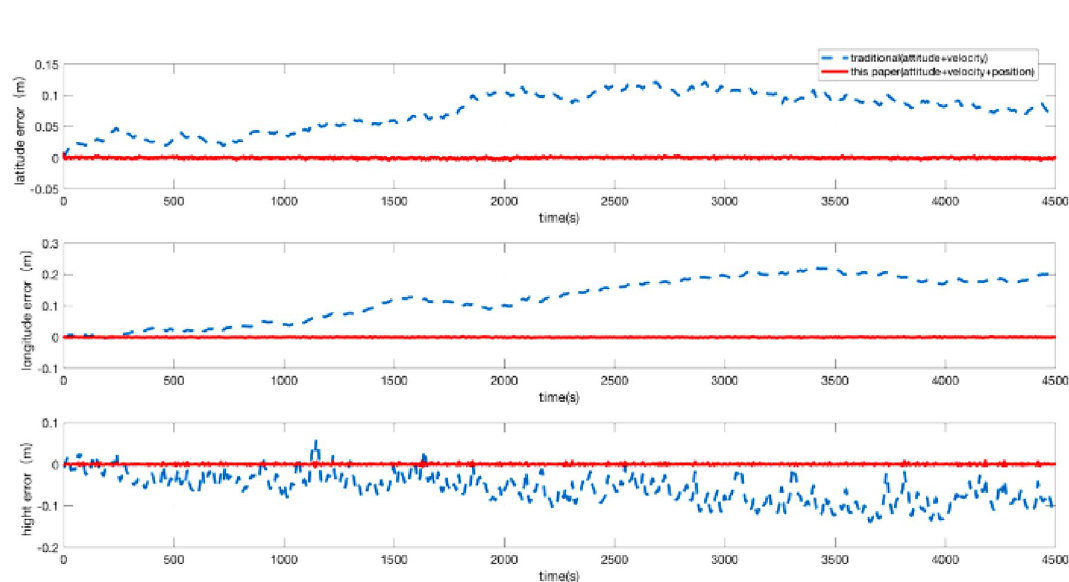
Figure 4. Position error of the POS.